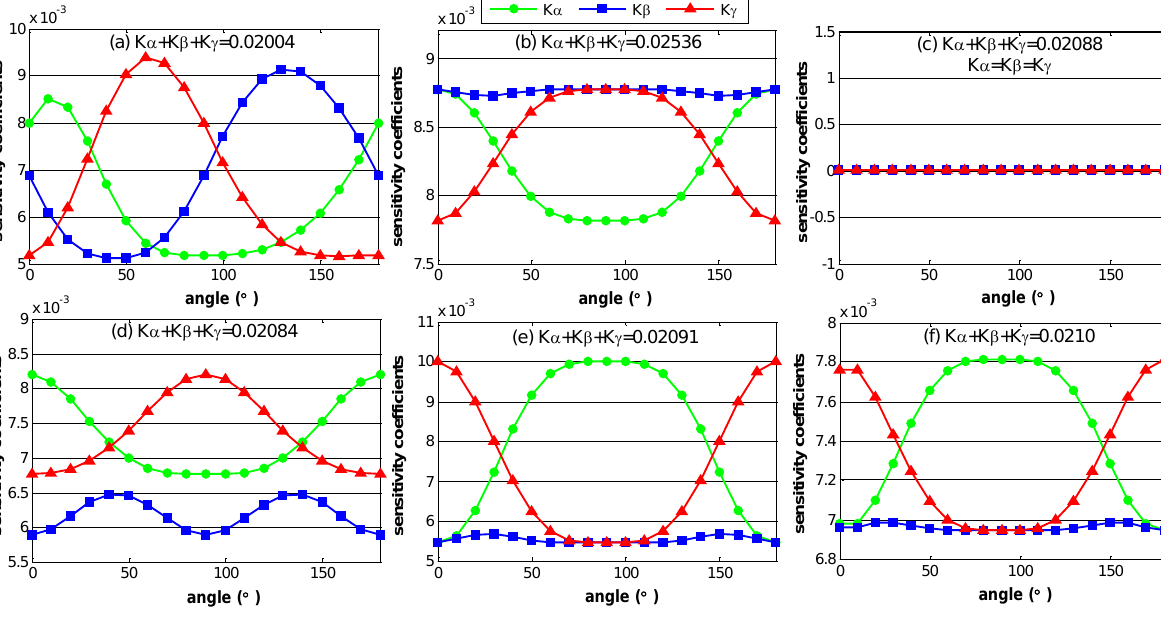
Figure 7. The fluctuation of sensitivity coefficients of rotation parameter errors. ( a ) Sensitivity coefficients of layout a; ( b ) Sensitivity coefficients of layout b; ( c ) Sensitivity coefficients of layout c; ( d ) Sensitivity coefficients of layout d; ( e ) Sensitivity coefficients of layout e; ( f ) Sensitivity coefficients of layout